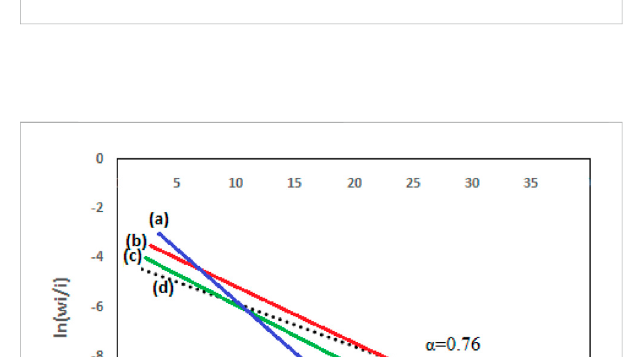
FIGURE 7 FT-product collection.